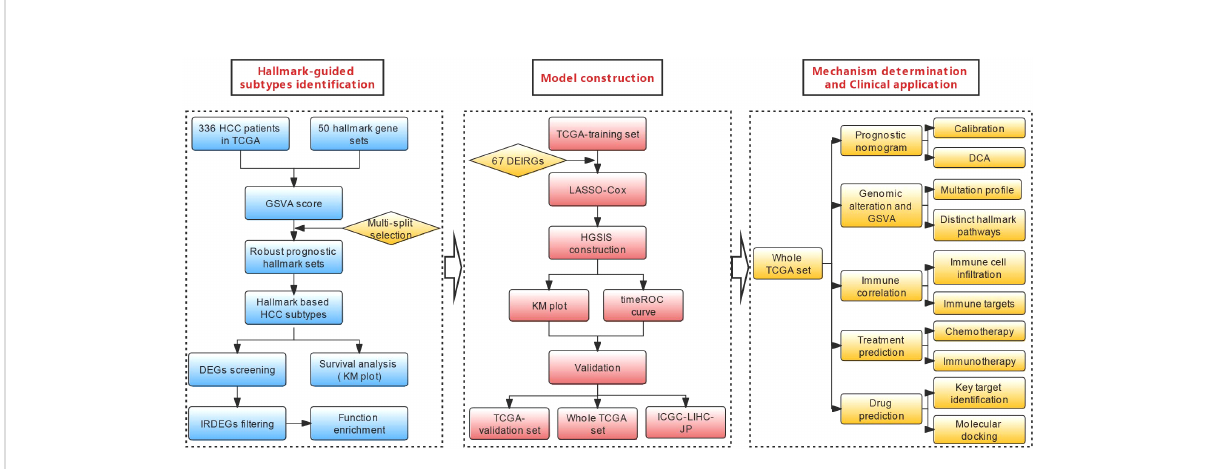
FIGURE 1 Flowchart of the current